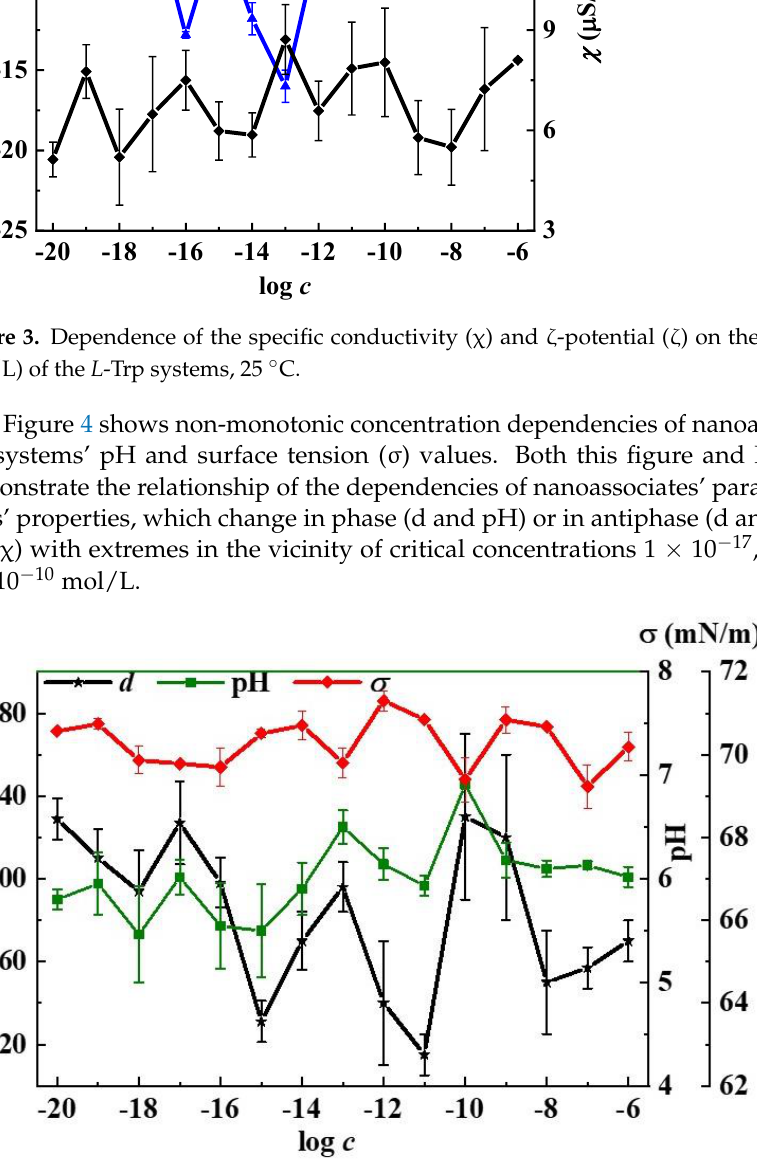
Figure 4. Dependence of the size of particles (d), pH, and surface tension (σ) on the concentration (c, mol/L) of the L -Trp systems, 25 °C.